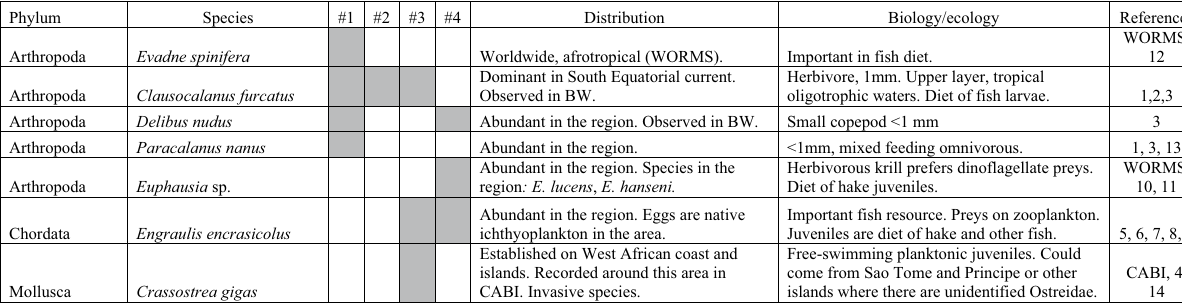
Table 2. Biological and ecological traits of zooplankton species found from NGS metabarcoding in West African high seas. Presence of species in each sampling zone are marked with gray